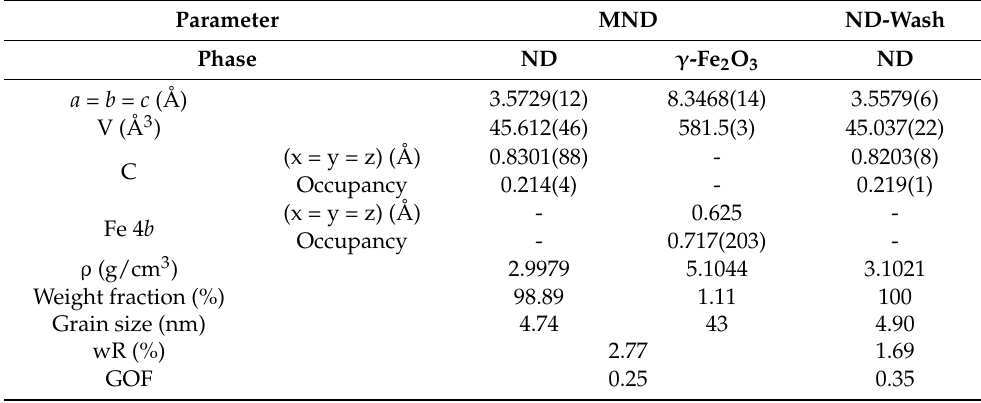
Figure 1. ( a ) The Rietveld refined (red line) powder X-ray diffraction (PXRD) diffractogram (open dots) of magnetic nanodiamond (MND). The green and blue lines represent the background and the difference between experimental and fitted diffractogram. The vertical black and red lines at the bottom of the figure mark Bragg’s positions for ND and γ -Fe 2 O 3 phases, respectively. ( b ) A unit cell of ND and γ -Fe 2 O 3 (top to bottom) with fitted values of lattice constant and the space group. Table 1. Summary of the Rietveld refined PXRD fitting parameters obtained from MND and ND-w samples. The atomic positions: Fe 12 d (x = 0.125 Å, y = 0.369(6) Å, z = 0.881(6) Å); Fe 8 c (x = y = z = 0.975(3) Å); O 8 c (x = y = z = 0.875(16) Å); O